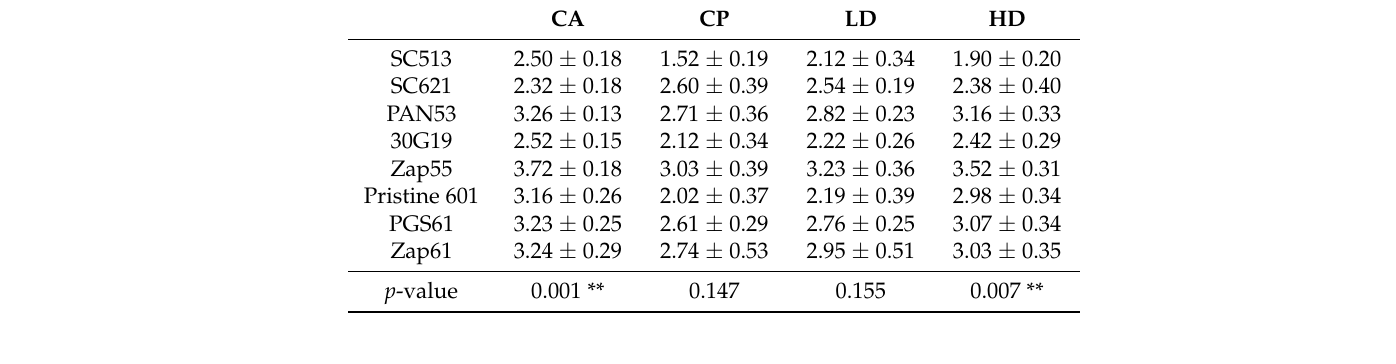
Table 3. Genotypic yield variability of the eight maize hybrids for each growing condition. Values are means ± standard error. Level of significance: **, p < 0.01. Treatments: CA, conservation agriculture; CP, conventional agriculture; LD, low density; HD, high